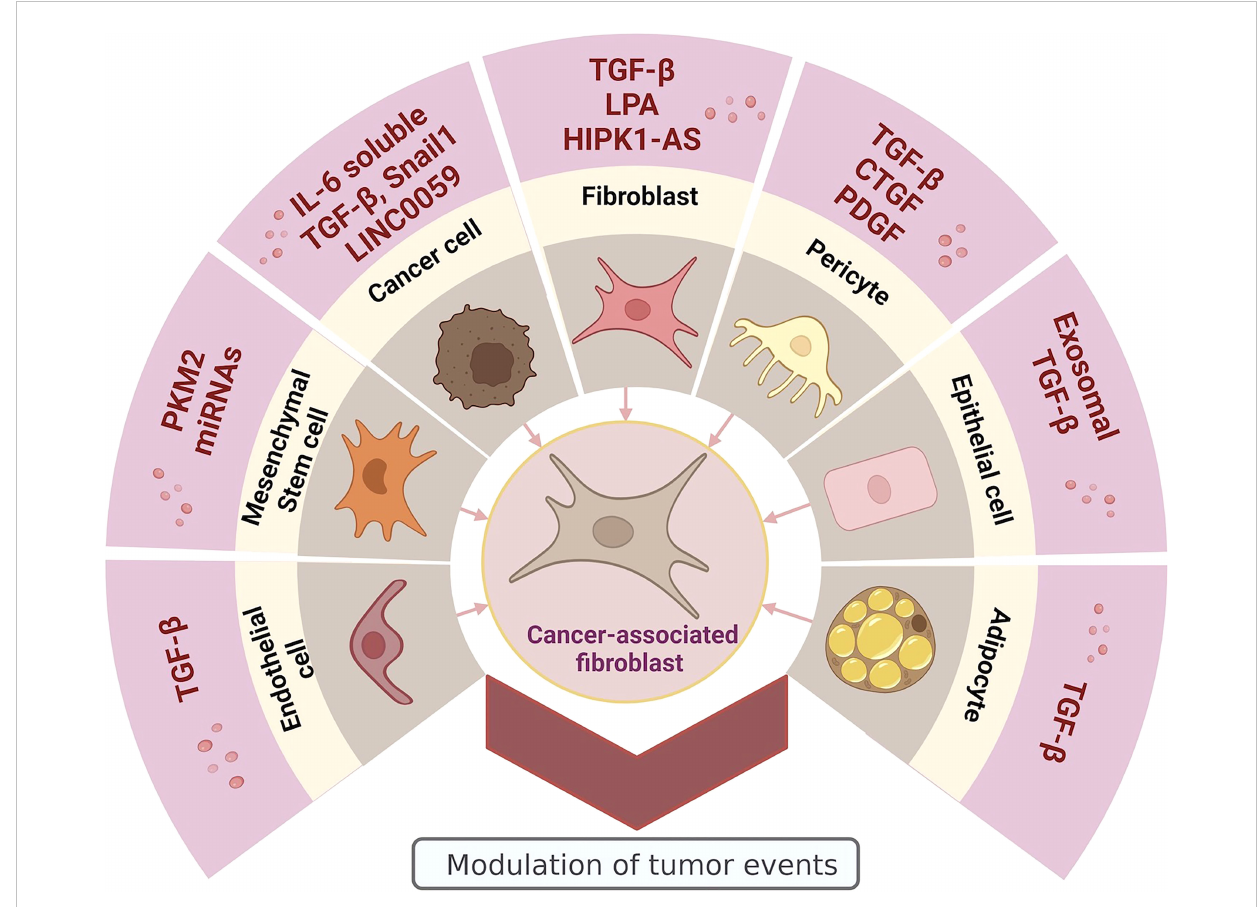
FIGURE 1 Heterogeneous origin of CAFs: promoter molecules and cellular sources. Image created in